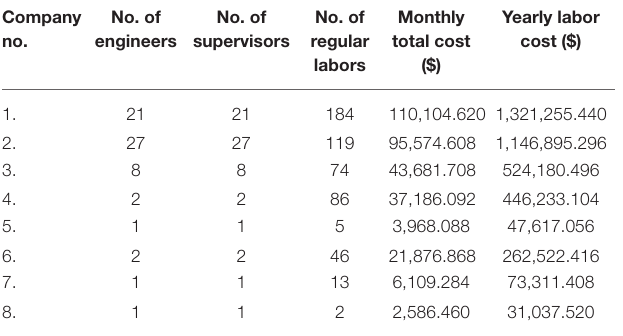
TABLE 2 | Number of Labor and their cost in the eight poultry companies in Kuwait. Company no.